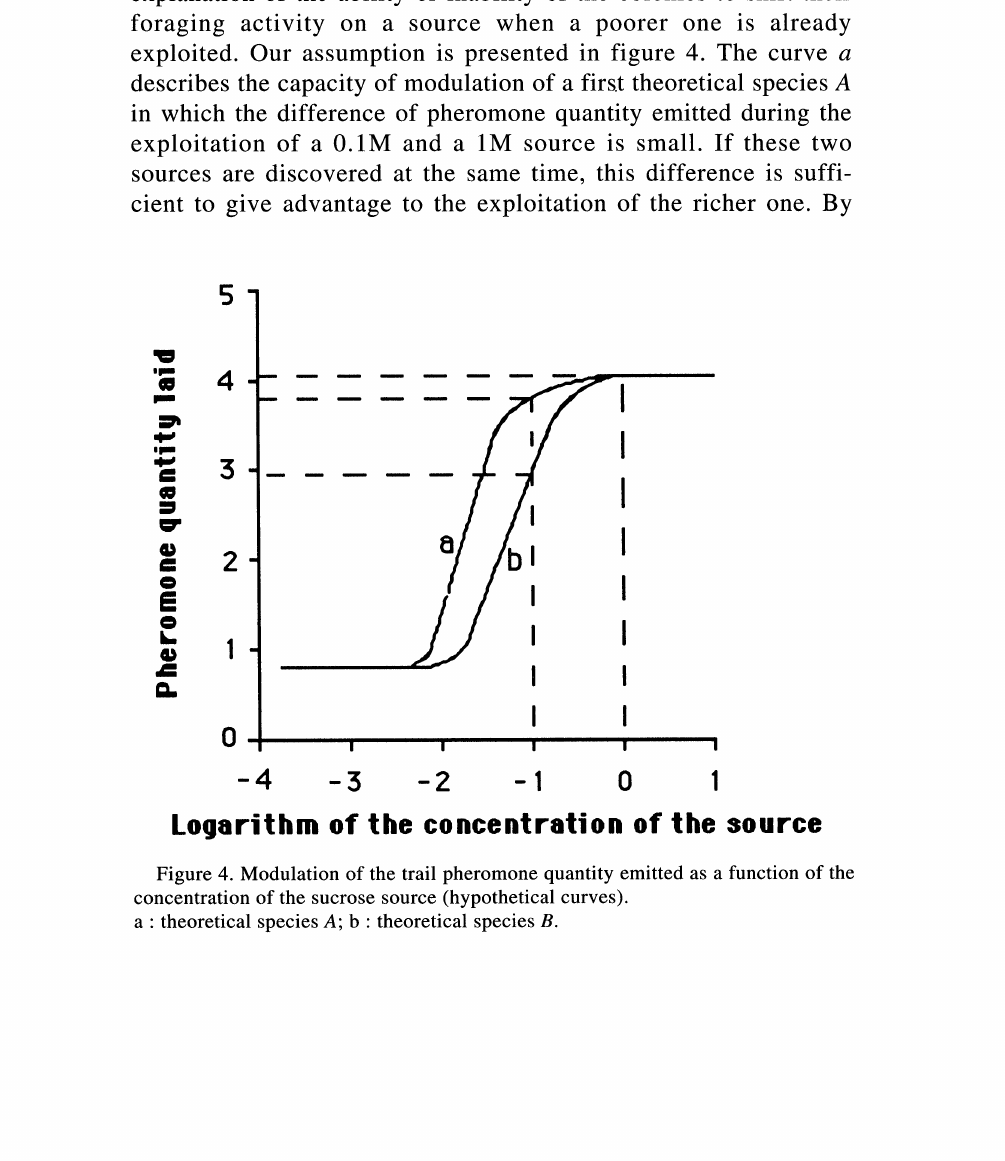
Figure 4. Modulation of the trail pheromone quantity emitted as a function of the concentration of the sucrose source (hypothetical curves). a theoretical species A; b theoretical species